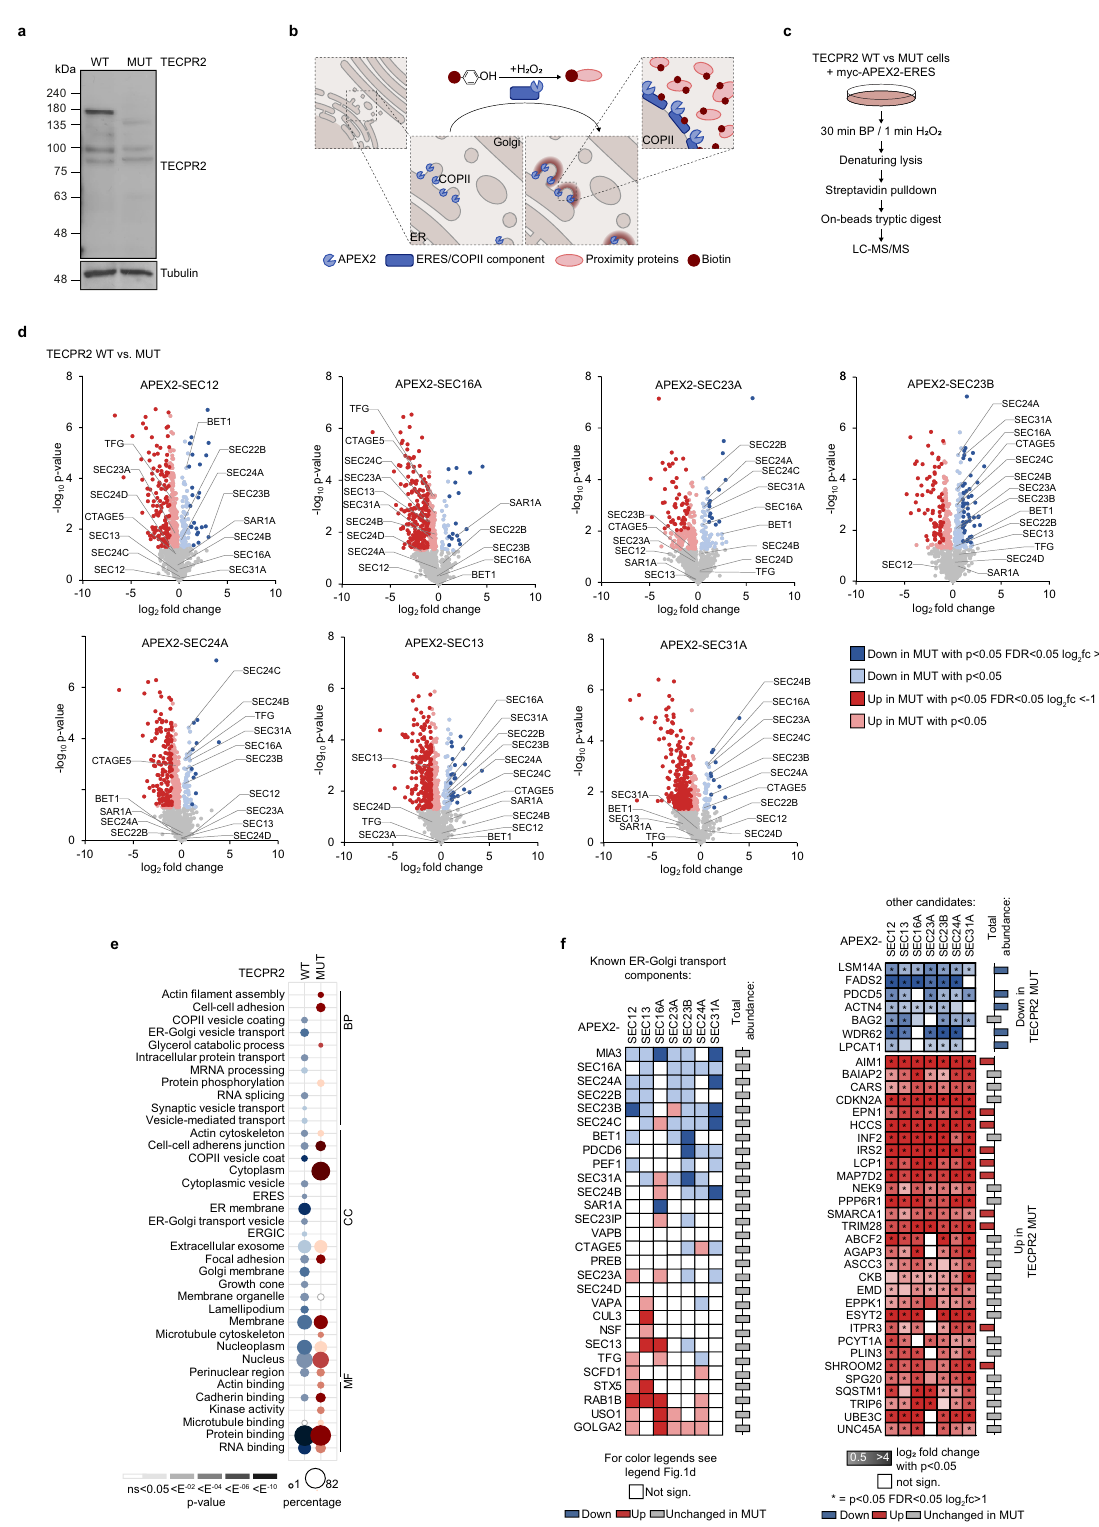
color legends see legend